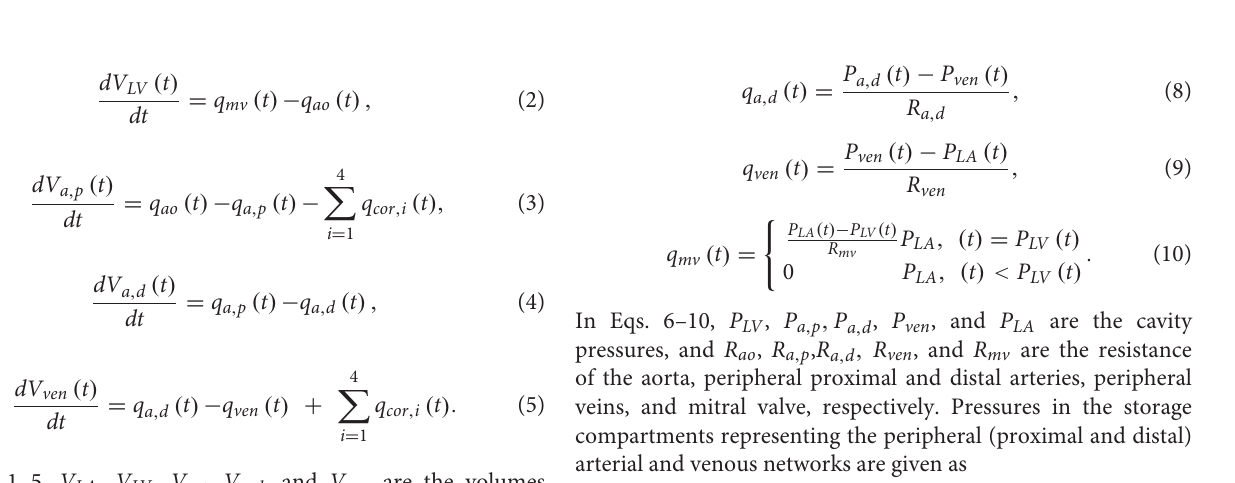
FIGURE 1 | Schematic of the cardiac-coronary computational framework. The LV FE model (with dimension given in the inset) is connected to four coronary networks located at different transmural location across the myocardial wall. Each network consists of 400 vessels with different vessel radius (see